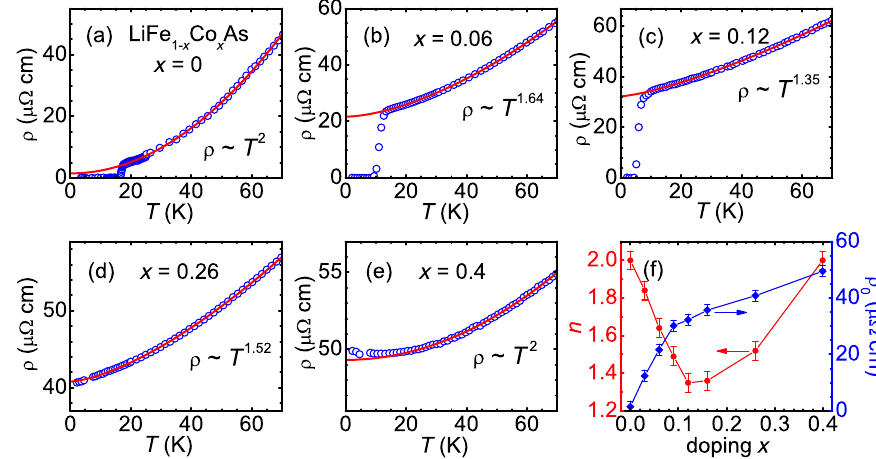
FIG. 1. (a) – (e) Resistivity as a function of temperature ρ ð T Þ (open circles) for LiFe 1 − x Co x As at five selected Co concentrations. For each material, ρ ð T Þ is fit to a single power law ρ ð T Þ ¼ ρ 0 þ AT n (solid lines). (f) Evolution of the exponent n (solid circles) and residual resistivity ρ 0 (solid diamonds) with Co substitution x